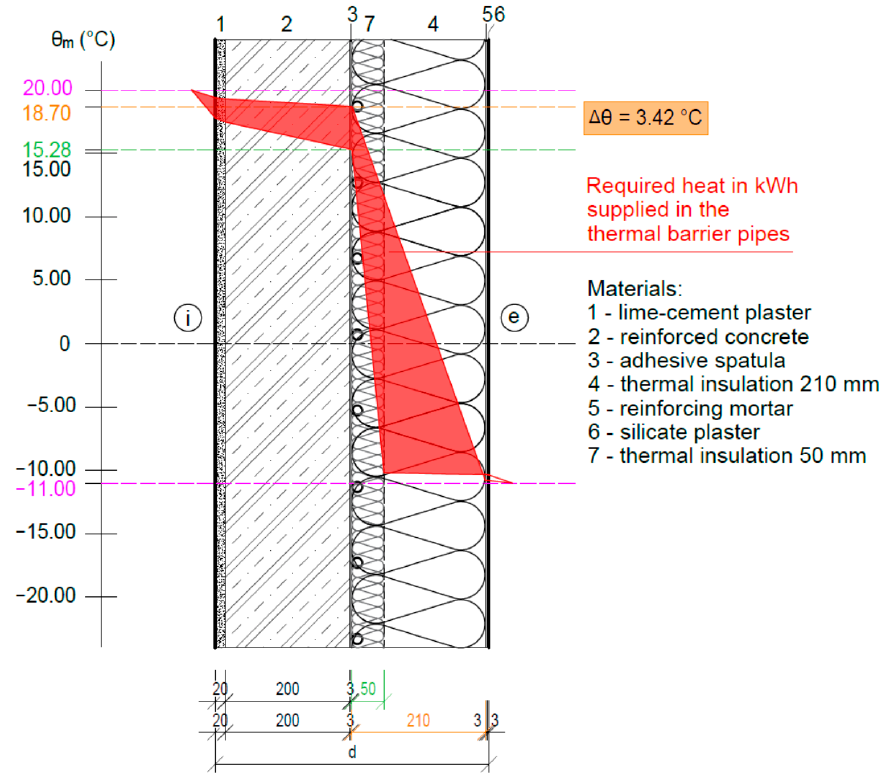
Figure 2. Heat delivered to the thermal barrier at a thermal insulation thickness of 50 mm to achieve the standard thermal resistance of the building structure.